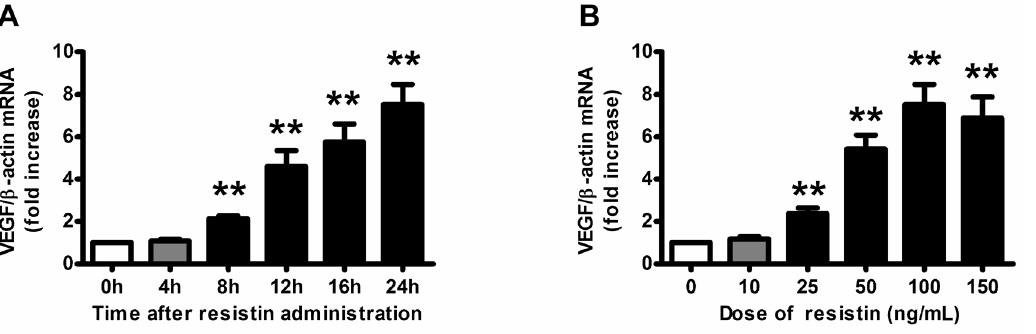
untreated cells; # p < 0.05, ## p < 0.01 vs. resistin treatment